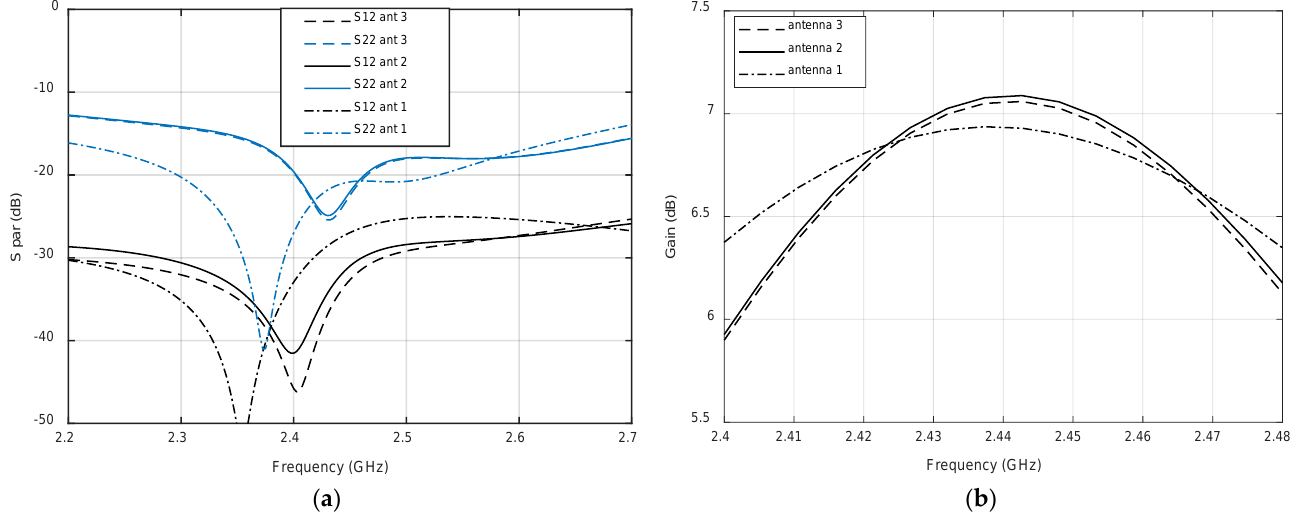
Figure 6. Simulated results for the three proposed antennas in the LoRa band: ( a ) scattering parameters; ( b ) gain. Figure 7 depicts the simulated RHCP (GPS band) and LHCP (LoRa band) realized gain radiation patterns for the two perpendicular cutting planes, Phi = 0 ◦ and Phi = 90 ◦ , along the axis perpendicular to the antenna. Both radiation patterns are almost symmetrical, with only small variations for different planes, especially in GPS band. The − 3 dB beamwidth for GPS band is around 88 ◦ and 77 ◦ for LoRa band. These wide beamwidths and uniform patterns are good for our application, limiting the gain loss in the critical case in which the UAV is just located between two faces of the sensor node hexahedron.